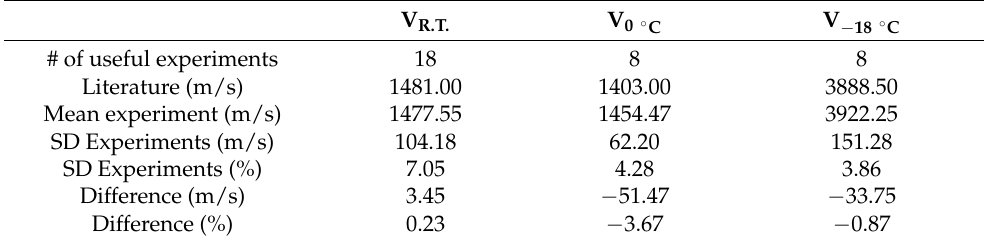
Table 3. Ultrasonic velocity values of all drop experiments compared with literature values [25]. The mean values and the standard deviations (SD) are included. Differences are given in m/s and in %. V